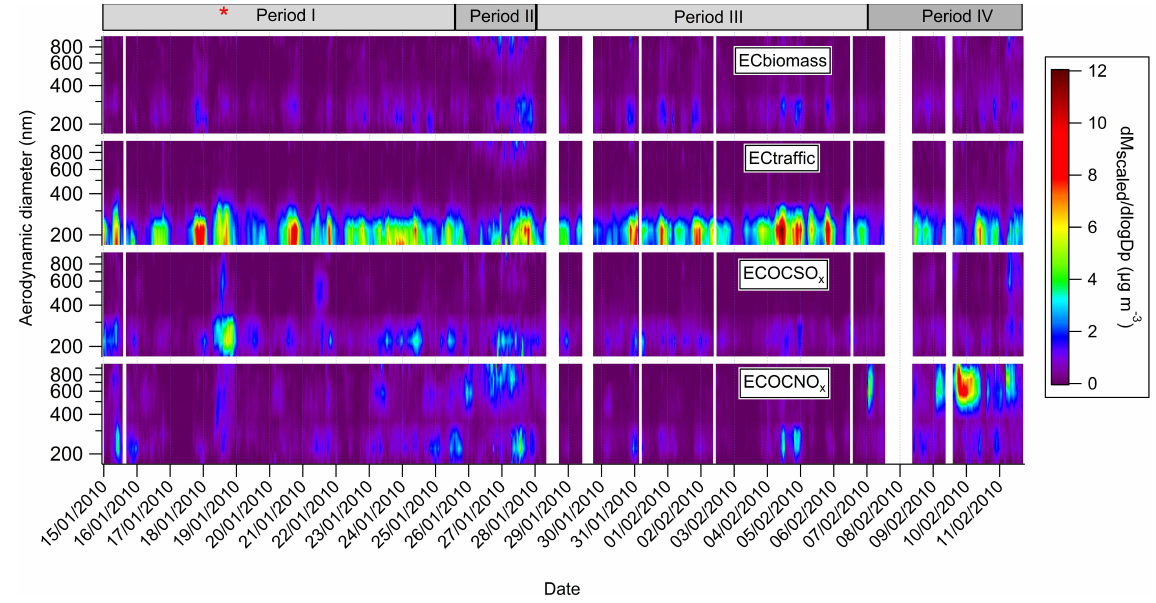
Fig. 6. Hourly scaled mass size distributions for the 4 ATOFMS EC